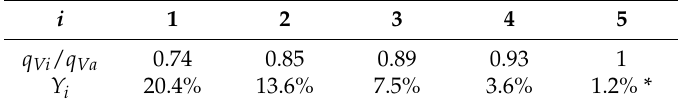
Table 3. Energy-saving rates of different flow-ratios. (*: accumulated